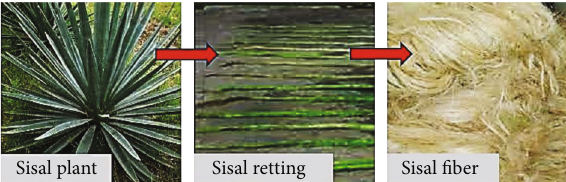
Table 2: L orthogonal array of hybrid nanocomposites. 9